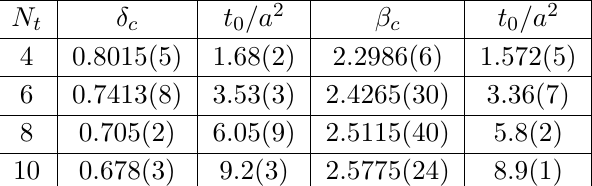
Table 3 . In(cid:12)nite volume extrapolated critical couplings and t 0 scale for both the topological and Wilson actions. The critical (cid:12) c for N t = 4 ; 6 ; 8 are from [17]. The errors on t 0 =a 2 contain the error of the critical couplings, that is why these errors are larger than those in table 1. The 4-volume for the scale measurements are the same as in table